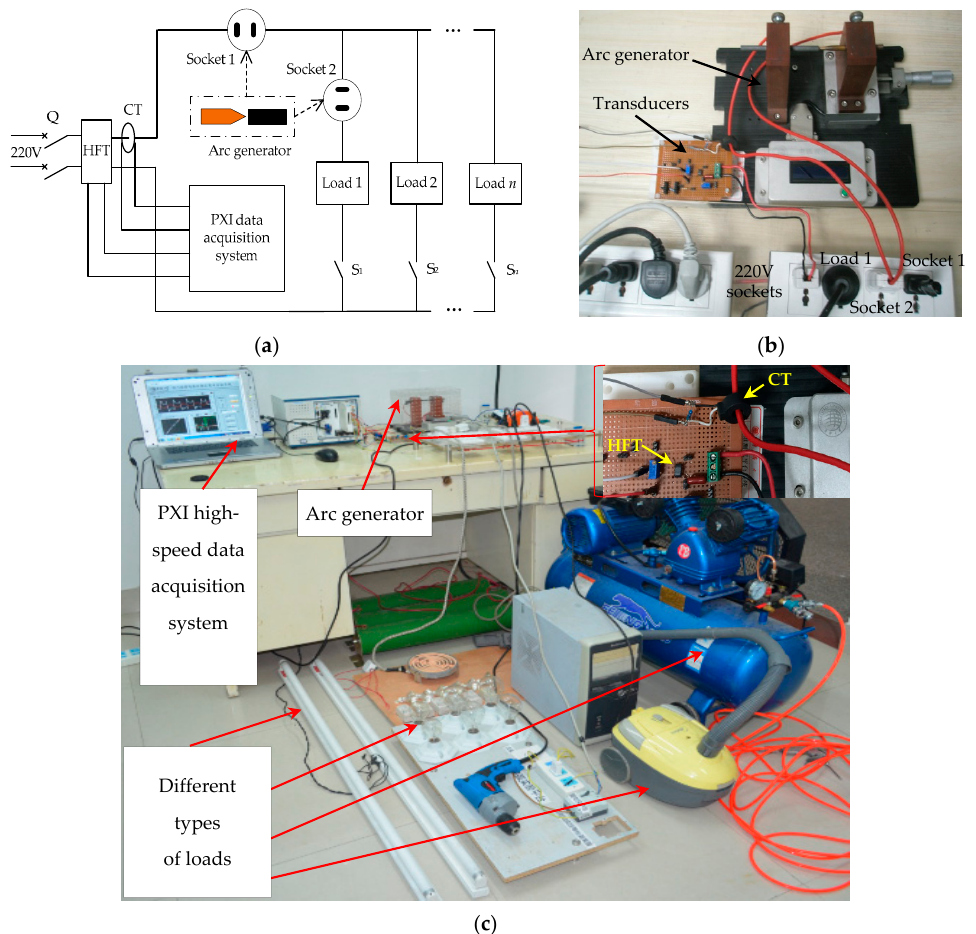
Figure 2. Experimental platform for electrical fire research: ( a ) schematic; ( b , c ) actual platform.